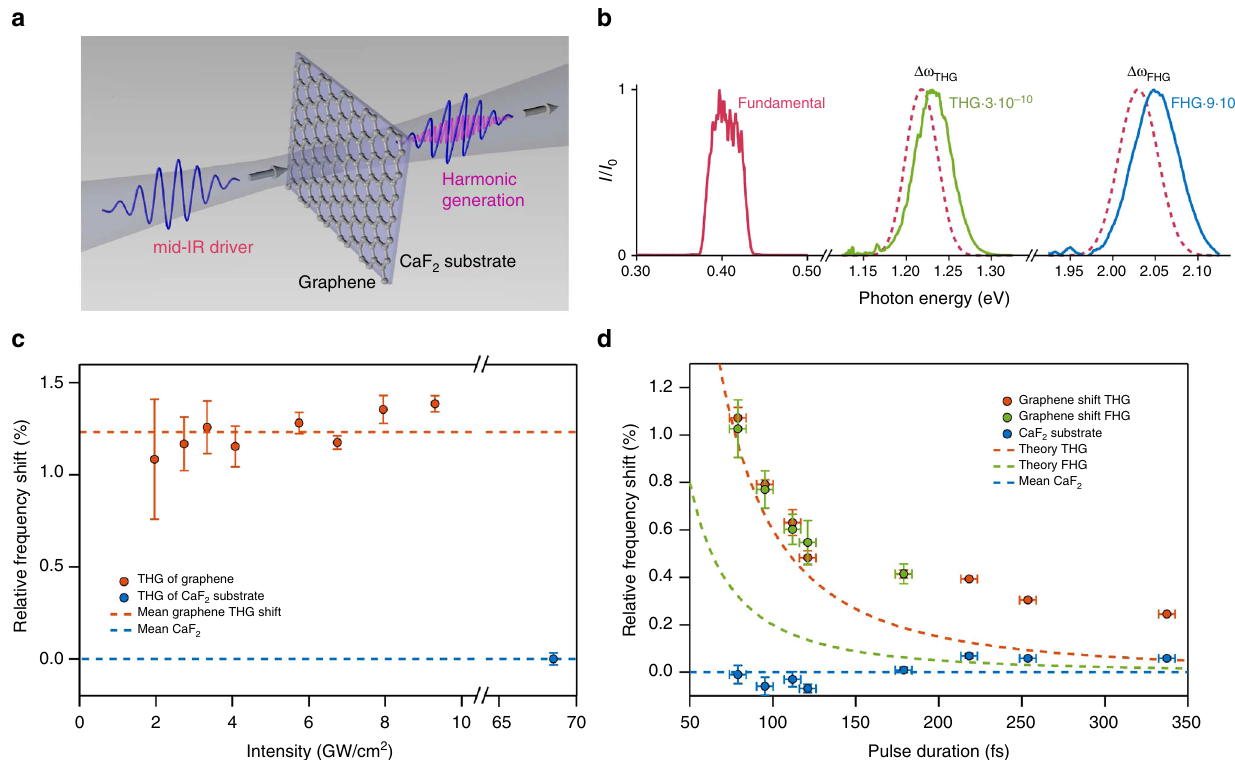
Fig. 2 Blue-shifted harmonics. a Schematic of the experimental con fi guration, showing the mid-IR fi eld (linearly polarized, 70-fs pulses at 3.1 μ m wavelength, i.e., E 0 = 0.4 eV photon energy) before and after propagation through 5 monolayers of graphene that are supported on a 0.4-mm thick CaF 2 substrate. Pulses of different durations and degrees of elliptical polarization are also investigated. b Measured fundamental spectrum, along with the emission at the third and fi fth harmonics (blue-shifted). The dashed curves represent the nominal position of the third and fi fth harmonic. c The resulting third harmonic is blue-shifted by 1.8% from 3 E 0 and the blue-shift is independent of driving fi eld intensity. d The blue-shift depends inversely on pulse duration for both the third and the fi fth harmonic. Note that, while in ( b ) we plot the absolute spectral shift, in ( d ) we plot the relative shift δω THG /3 ω and δω ω . The measurement errors are derived according to the error propagation law from the instrument measurement uncertainties, i.e., from the FHG /5 spectrometer, power meter, beam pro fi ler, and frequency resolved optical